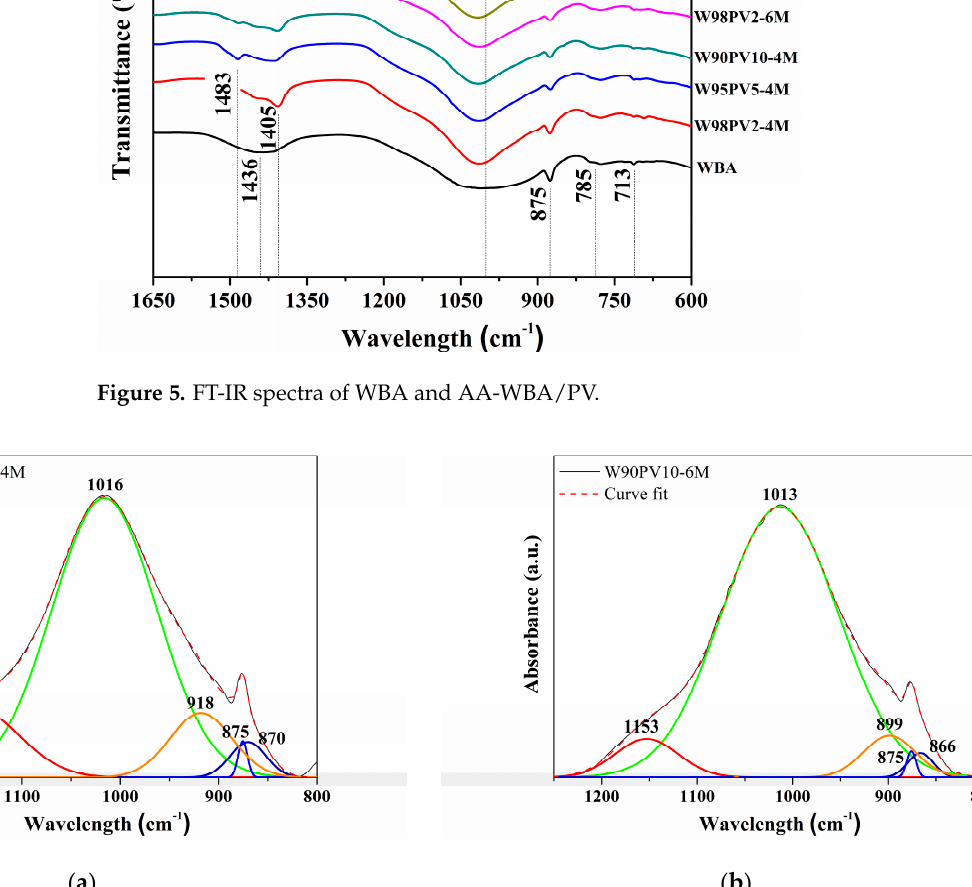
Figure 6. FT-IR deconvoluted spectra of ( a ) the W98PV2-4M sample and ( b ) W90PV10-6M sample. Figure 7 depicts the FT-IR spectra of the W98PV2-4M and W90PV10-6M samples be- fore and after the selective chemical extractions. The shift and displacement of the broad band (1009–1013 cm − 1 ) towards a higher frequency (1064 cm − 1 ) indicates the dissolution of the C-S-H, C-A-S-H, and (C,N)-A-S-H phases. The dissolution of these phases produced three characteristic peaks that indicate the presence of silica gel (790, 945, and 1064 cm − 1 )